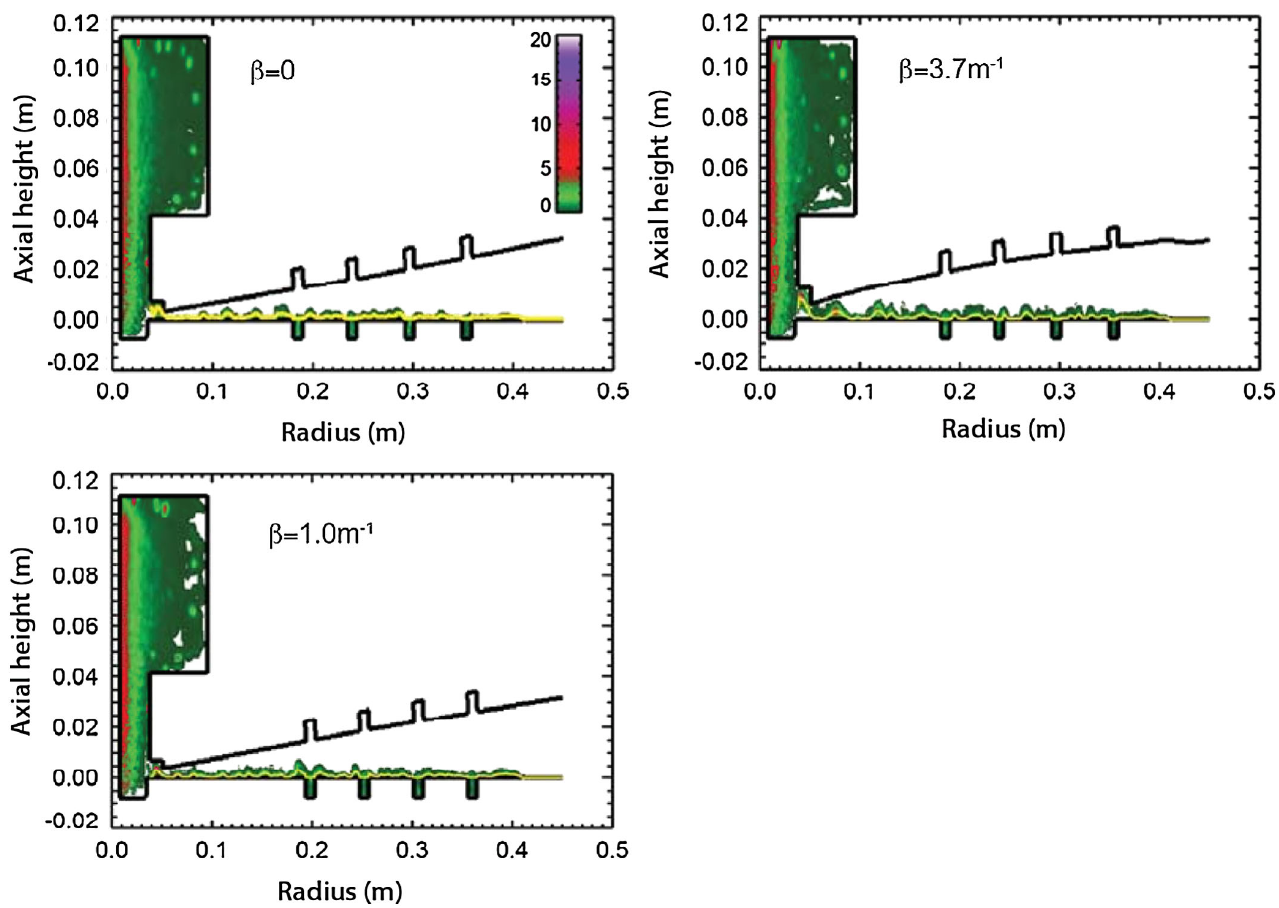
FIG. 8. (Color) Charge density [ C = m 3 ] for the (cid:2) ¼ 0 , 1, and 3.7 per meter radial profiles at high voltage ( V ¼ 5 MV ). The overlay of the mean position of the cathode space-charge illustrates the flow impedance of the MITL. This line is seen to ripple in the vicinity of electron vortices. As the retrapping rate increases, these vortices become more pronounced near the